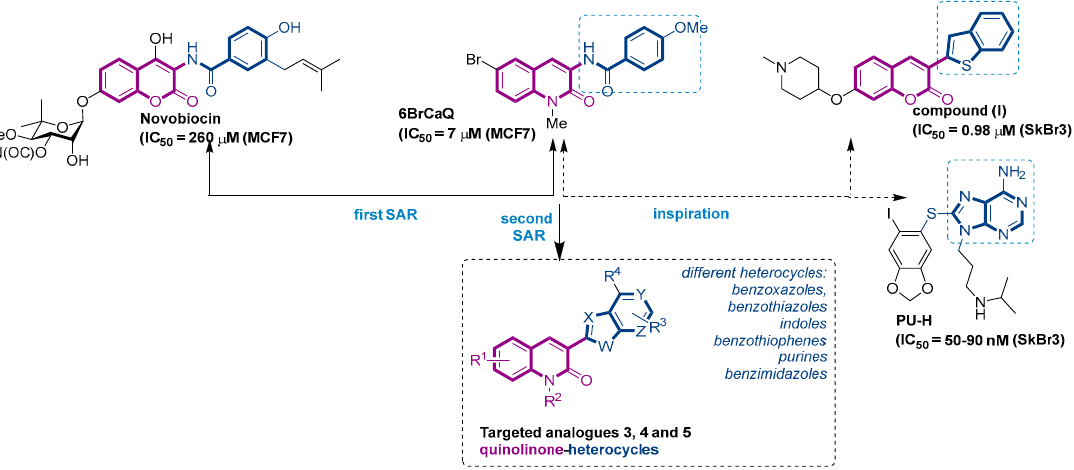
Figure 1. Structure of novobiocin and 6BrCaQ compounds and the approach for the design of targeted compounds 3 , 4 and 5 .